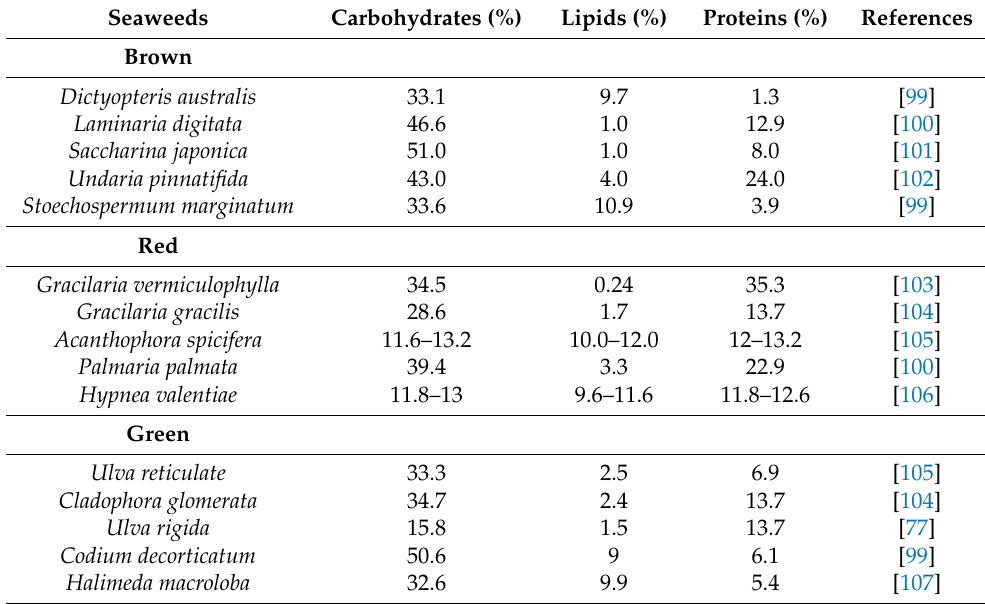
Table 4. The biochemical composition of representative brown, red, and green